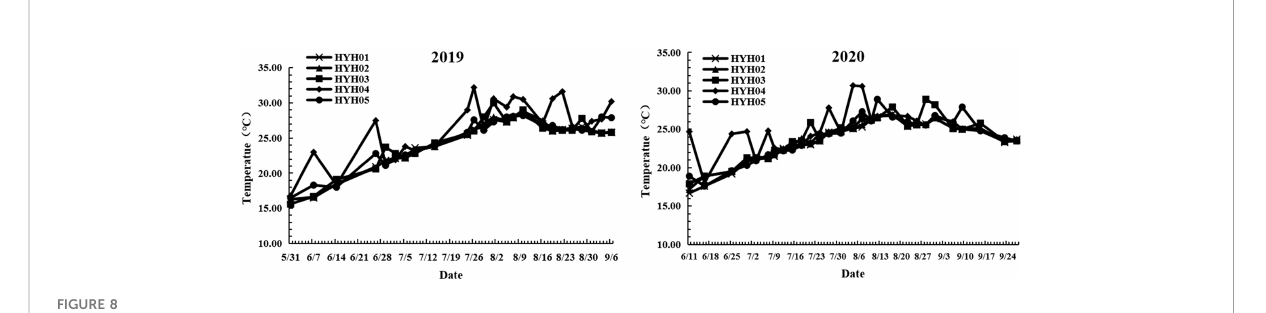
FIGURE 8 Fluctuations in the SST across the different stations in 2019 and 2020.